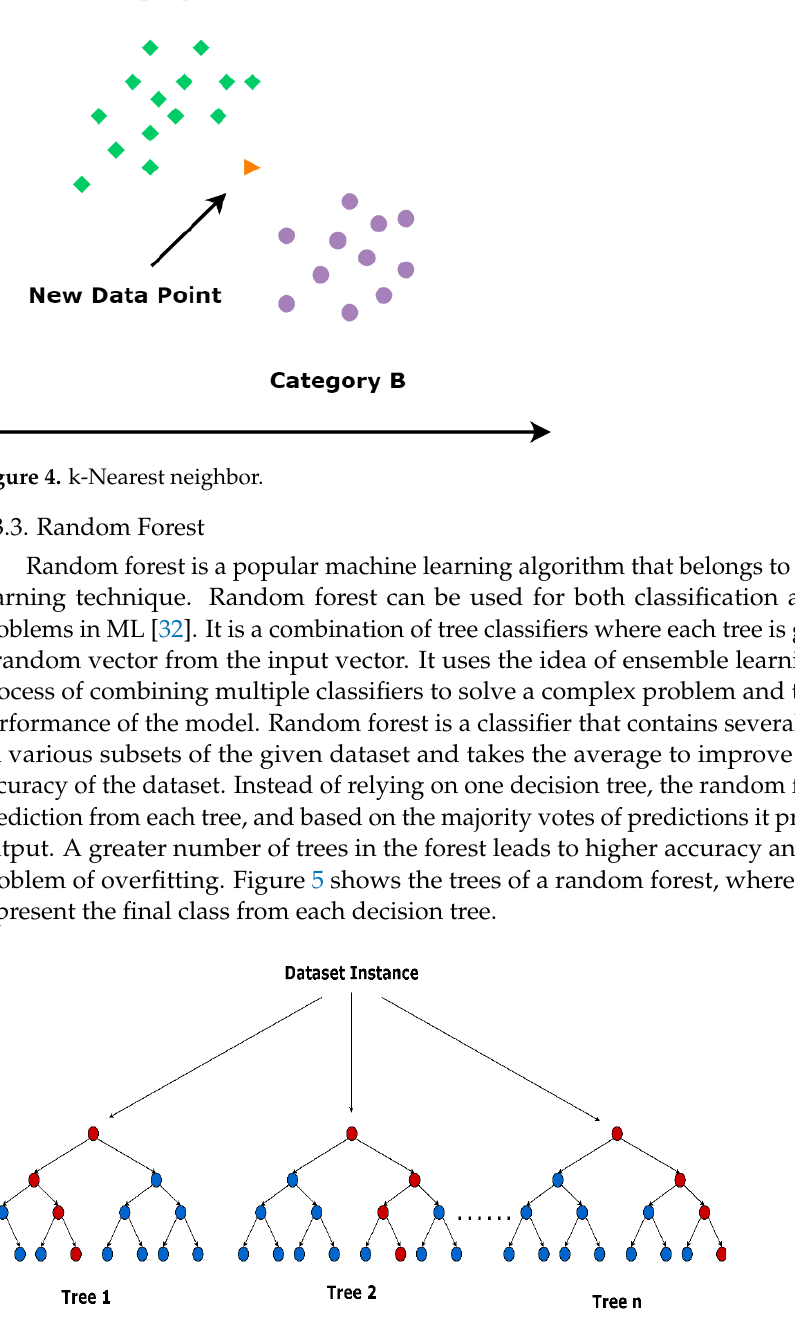
Figure 5. Random forest. Figure 5. Random